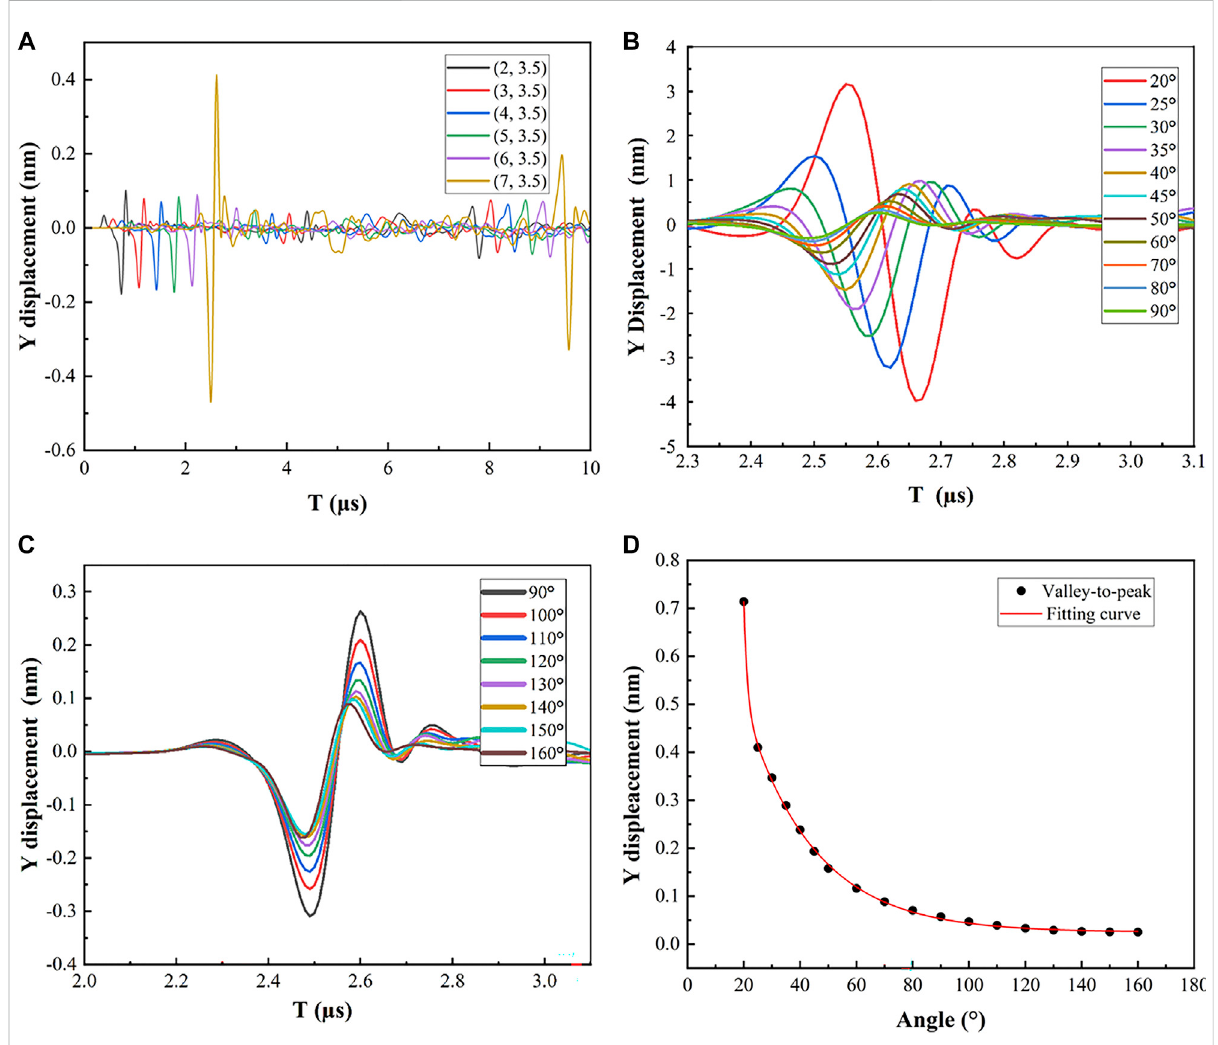
FIGURE 8 YdisplacementandFittingcurve: (A) Ydisplacementcomponentsdetectedbydifferentdetectionpointsat70 ° ; (B) Displacementofcrackswith